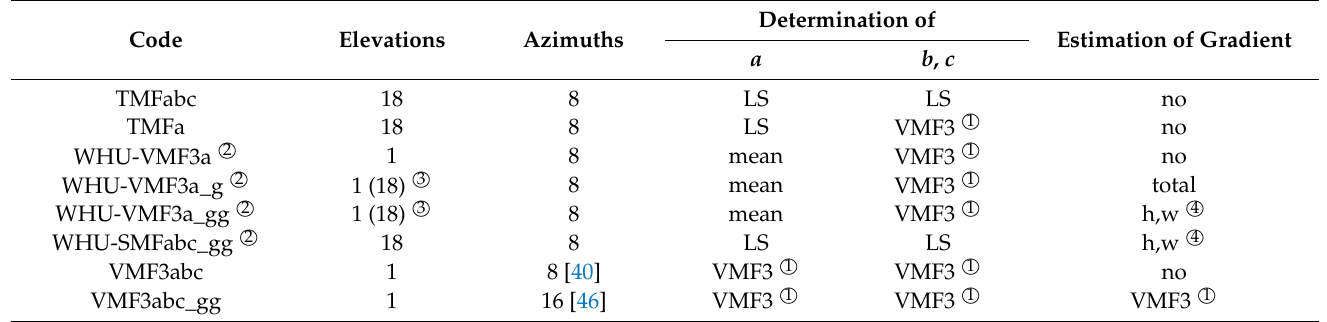
Table 2. A list of approaches for mapping functions and gradients used in this